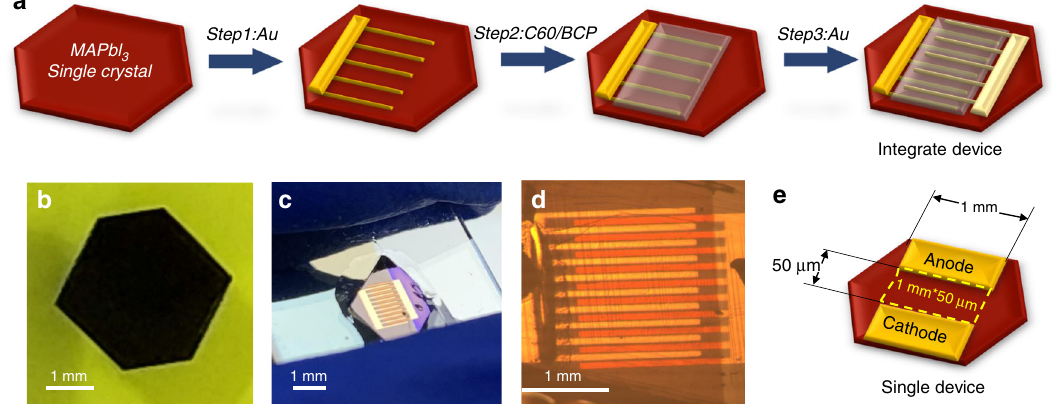
Fig. 1 Fabrication of lateral structure perovskite solar cells. a Schematic diagram of preparation process of large-area lateral structure perovskite single crystal solar cells. b Image of the MAPbI 3 single crystal. c and d Photographs of the lateral-structure SC-PSCs. e Structure of a regular single device with area of 50 μ m × 1 mm. The large-area device was integrated by 19 single devices (65 μ m × 1.5 mm) with total device area of 1.85 mm